Question: Summarize what this figure shows in one sentence.
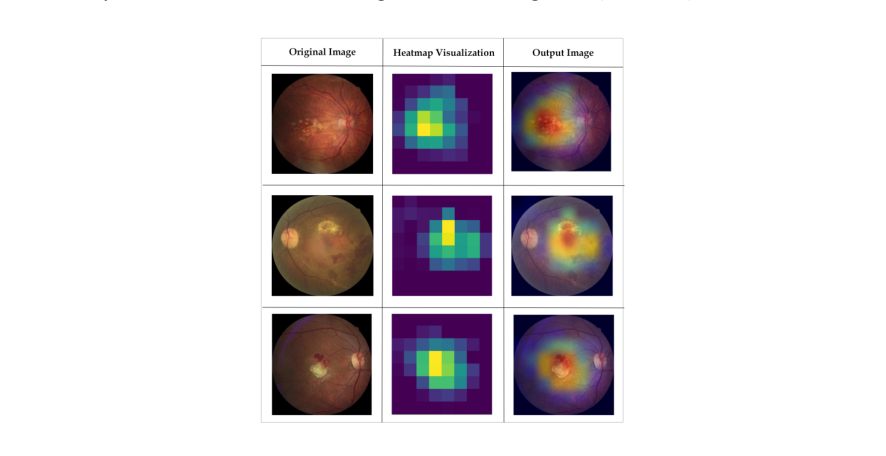
Answer: The Localization of Macular Degeneration using Grad-CAM Method. Left: Original Input Images. Middle: Heatmap Generated from the input image Right: Su- perimposed Output Images localizing the effected region.